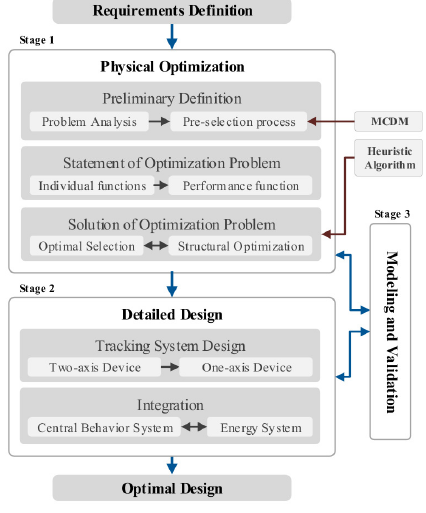
Figure 3. Proposed strategy for the optimal design of dual-axis solar